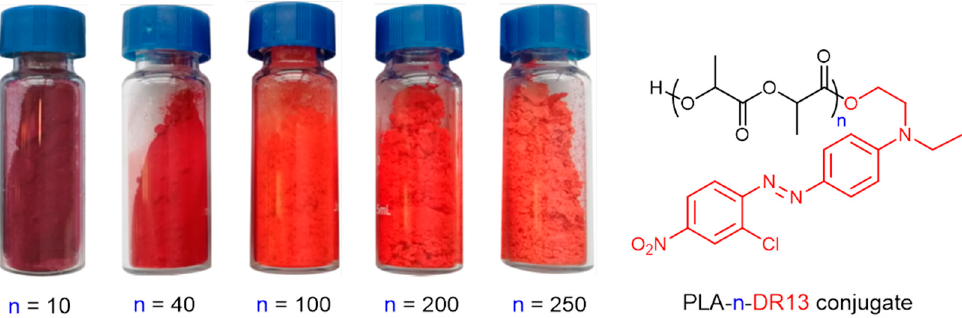
Figure 7. PLA-n-DR13 conjugate samples with controlled molecular weights.